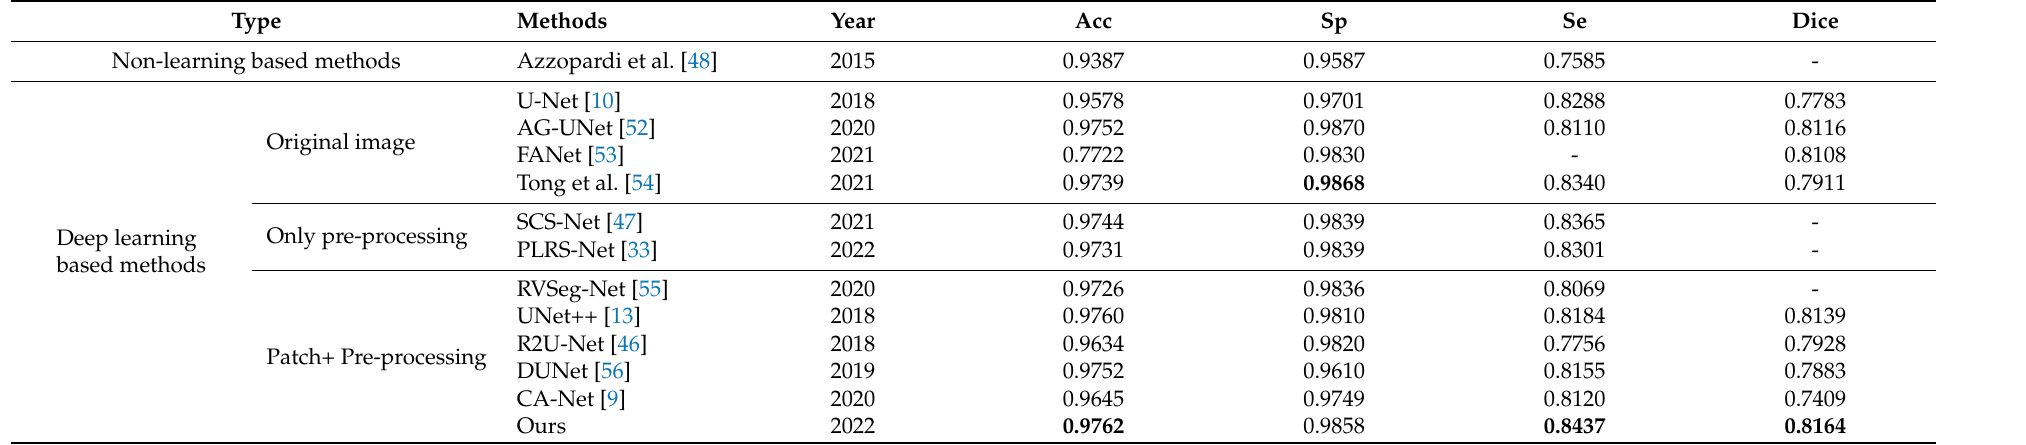
The bold data in the table represent the maximum value achieved on each evaluation